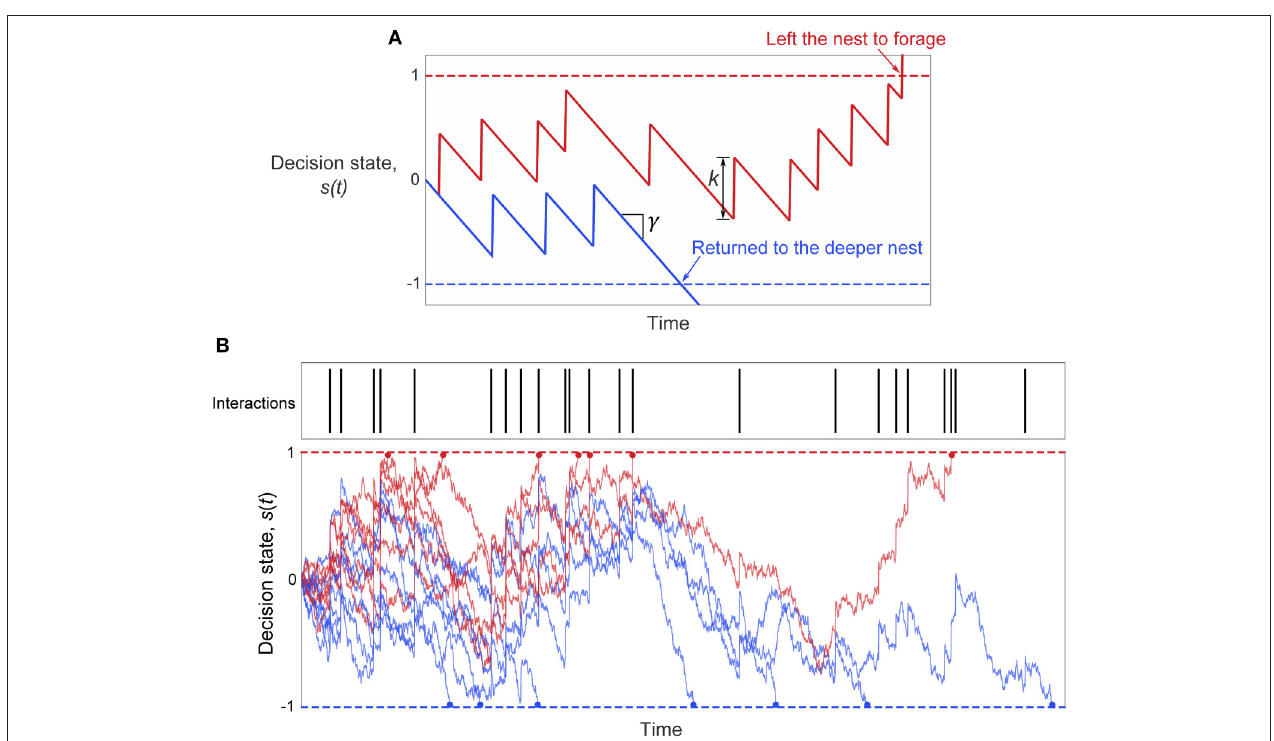
FIGURE 5 | The two-choice model of ant foraging decisions. (A) Illustration of the decision model parameters. Noise is omitted to better illustrate the roles of the parameters γ and k (see Equation 2) in determining the ant’s decision in response to interactions. The bias rate γ sets the mean rate of change of the decision state in the absence of interactions, and k sets the increase in the decision state with each interaction. The initial decision state is set by the parameter s 0 , and is set to zero for this example. (B) Example trajectories of the decision state with noise for the set of interaction times shown. Red lines: decision state s ( t ) of simulated ants that left the nest to forage. Blue lines: decision state s ( t ) of simulated ants that returned to the deeper nest. The decision time is shown by the dot at the end of each simulated decision